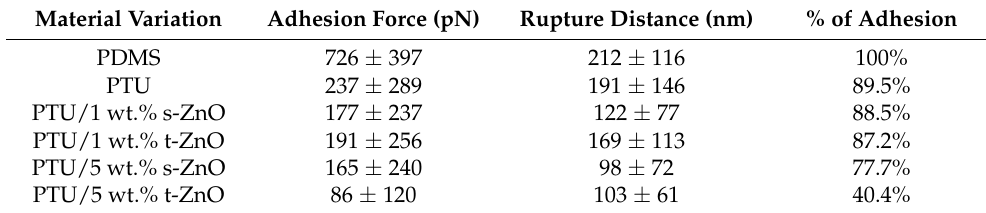
Table 5. Mean adhesion forces and rupture distances of S. aureus on a variation of six different material surfaces. The right column presents the percentage of curves presenting adhesive events. Material Variation Adhesion Force (pN) Rupture Distance (nm) % of